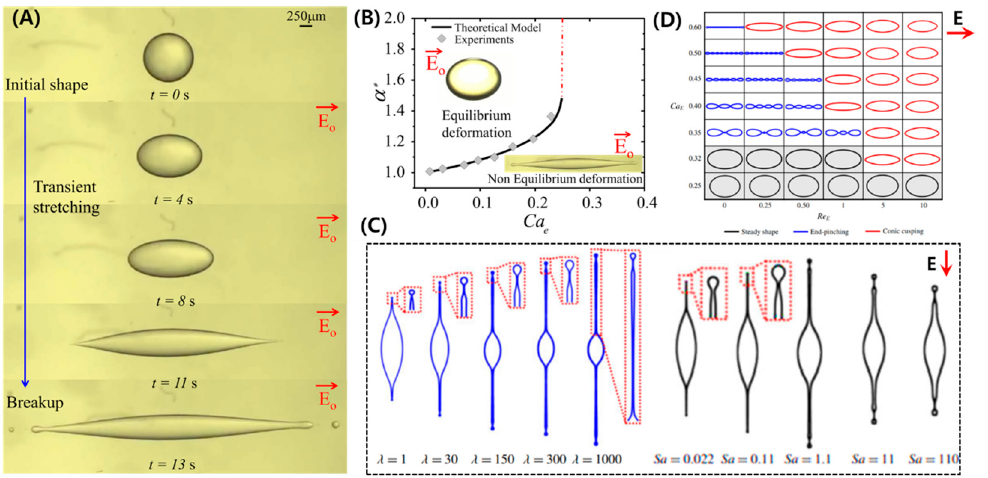
Figure 4. Breakup of a prolate droplet under a strong DC electric field. ( A ) Transient evolution of a castor droplet in silicone oil and breakup at the side ends. ( B ) Non-dimensional stretching vs. electric capillary number leading to instability (reproduced from [15] with permission from The Royal Society of Chemistry). ( C ) Effects of viscosity ratio and liquid conductivity (in terms of Saville number) on the droplet shapes [114] . ( D ) Droplet breakup mode transition depending on electric Reynolds Number [115] .